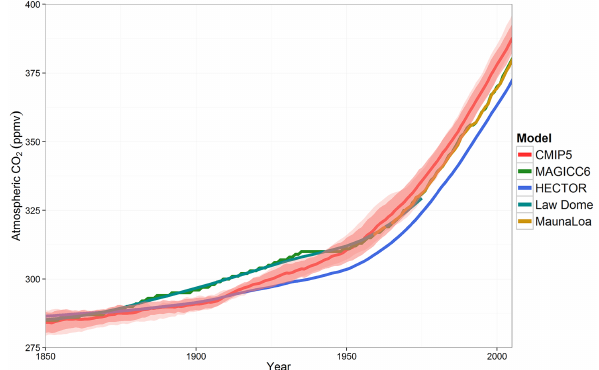
Figure 3. Historical atmospheric [CO 2 ] from 1850 to 2005 for Hec- tor (blue); CMIP5 median, standard deviation, and model range (pink, n = 4); MAGICC6 (green); Law Dome (teal); and Mauna Loa (brown). Note CMIP5 data are from the prescribed emissions historical scenario (esmHistorical). MAGICC6, however, is con- strained to match the observational record. Although Hector can be run with similar constraints, in this study Hector was unconstrained to highlight the full performance of the model. n = 4 is the number of CMIP5 models used to produce this